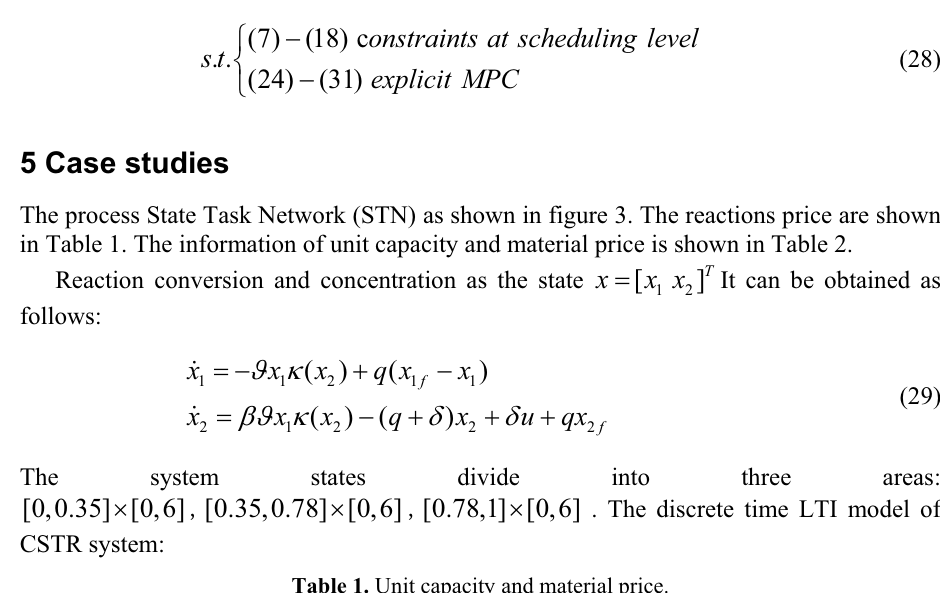
Table 1. Unit capacity and material